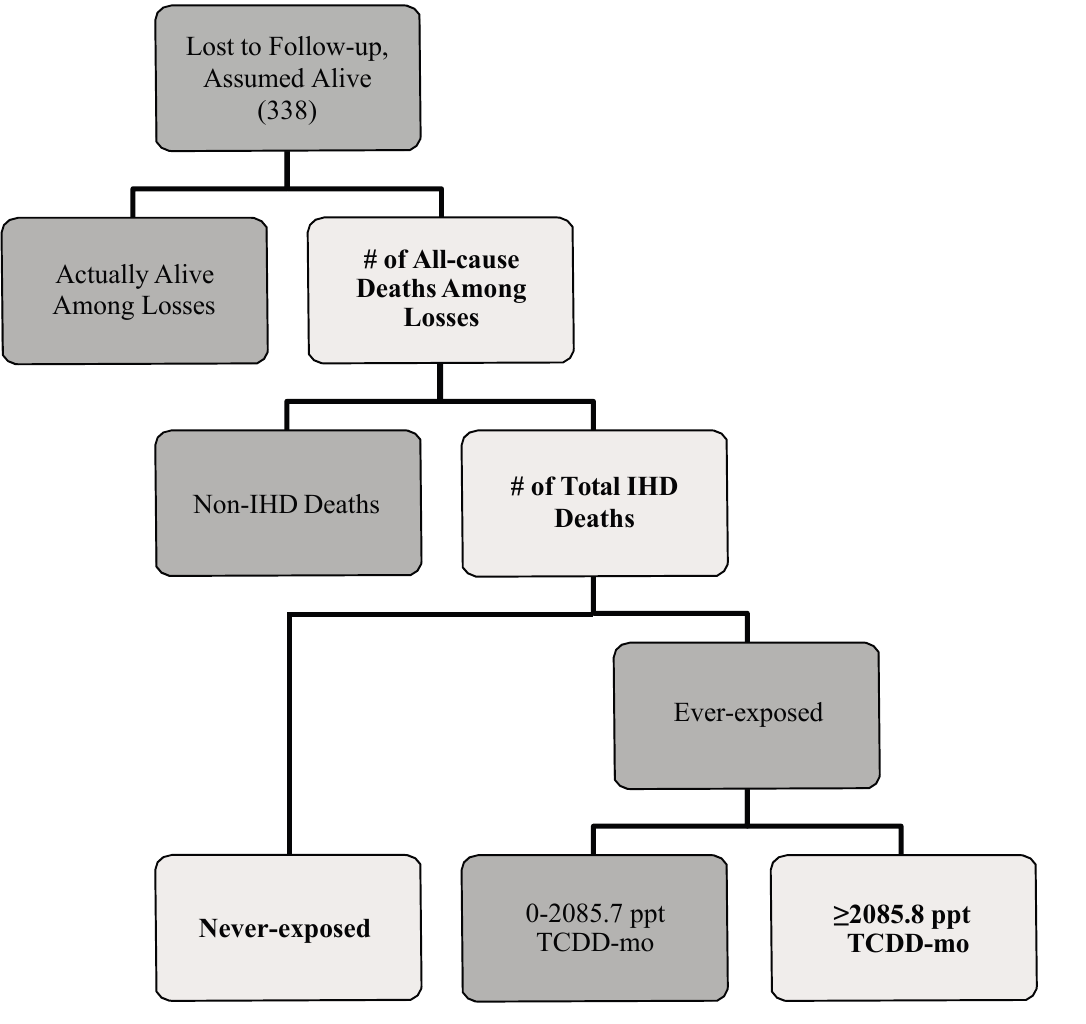
Figure 1. Flow diagram describing how losses to follow-up in Mcbride et al. [13] could result in outcome misclassification. Lighter shapes with bolded text indicate the parameters that were specified in our bias